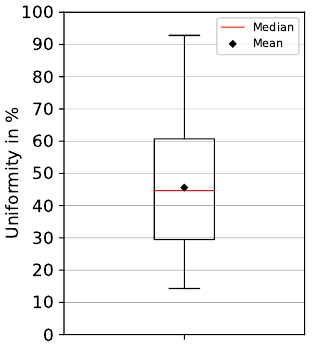
Figure 8. PUF uniformity box